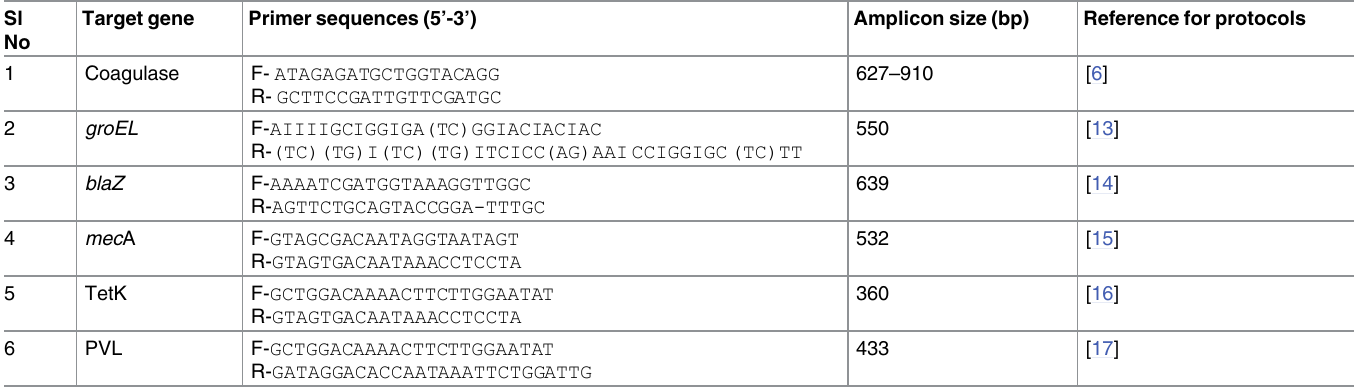
Table 1. Target genes and primers used to identify S. aureus and coagulase-negative Staphylococci by PCR.